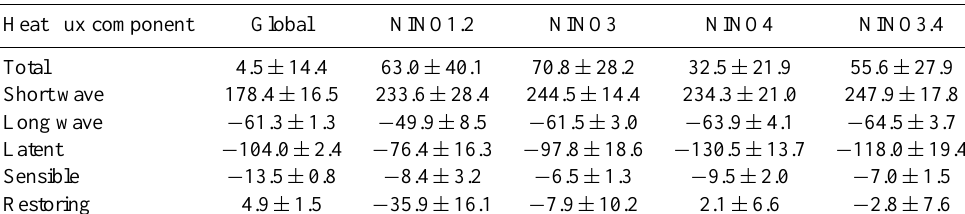
Table 1. Time mean plus/minus the standard deviation (Wm − 2 ) of the area-averaged surface heat flux components for the full model domain (column 2), and for each of the NINO regions (columns 3–6) presented in Fig. 6.